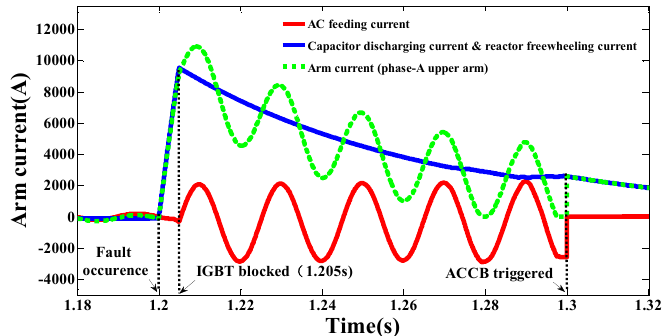
Figure 10. Phase-A upper arm current under the DC pole-to-pole fault.